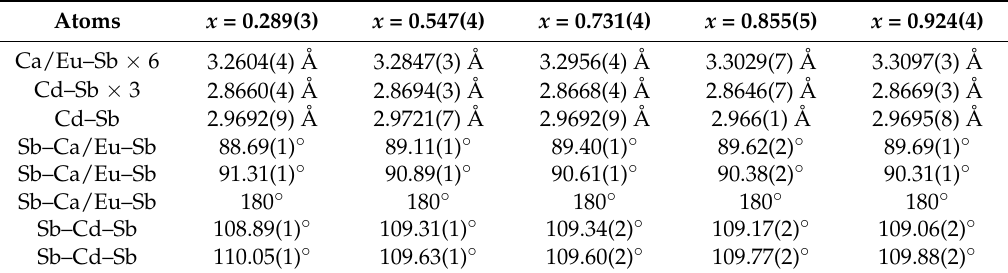
Table 3. Selected bond lengths and angles for Ca 1 − x Eu x Cd 2 Sb 2 with varied x .